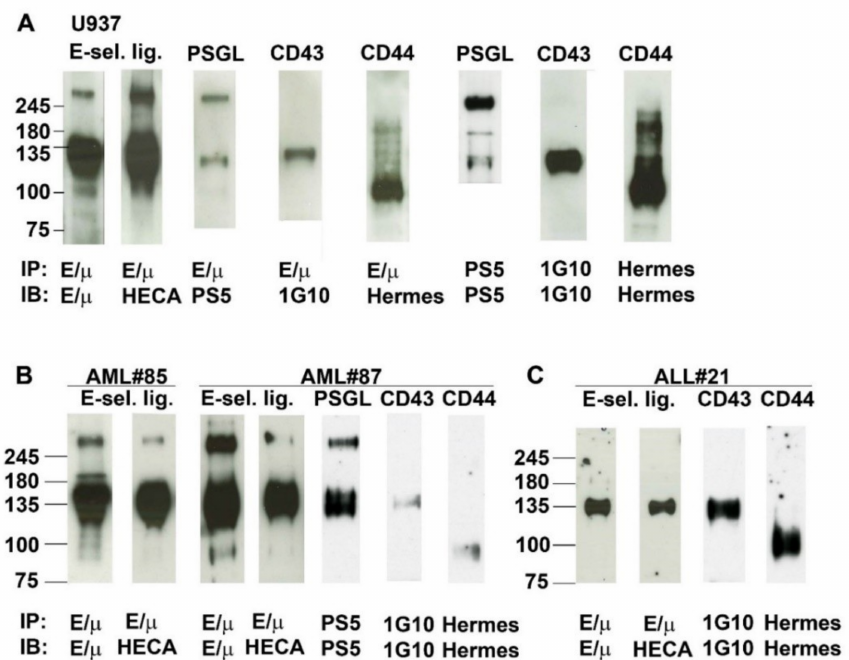
Figure 5. Analysis of E-selectin ligands expressed by myeloblasts and lymphoblasts: contribution of P-selectin glycoprotein ligand-1 (PSGL-1), CD44 and CD43. E-selectin ligands expressed by ( A ) U937 monoblasts or ( B ) myeloblasts obtained from AML#85 or AML#87 or ( C ) lymphoblasts from ALL#21. Blast lysates were adsorbed on protein G-Sepharose beads coated with goat anti-human IgM heavy chain precomplexed with E-selectin / µ chimera. E-selectin ligands were revealed by western blotting using E-selectin / µ chimera or HECA-452 mAb that reacts with cutaneous lymphocyte antigen (CLA), the anti-PSGL-1 mAb PS5, the anti-CD43 mAb 1G10, and the anti-CD44 mAb Hermes-1. In parallel, PSGL-1, CD43, and CD44 were immunoprecipitated, separately, to completion from cell lysates with PS5, 1G10 and Hermes-1 mAbs and revealed using the same antibodies. Panel A illustrates results from one representative experiment out of